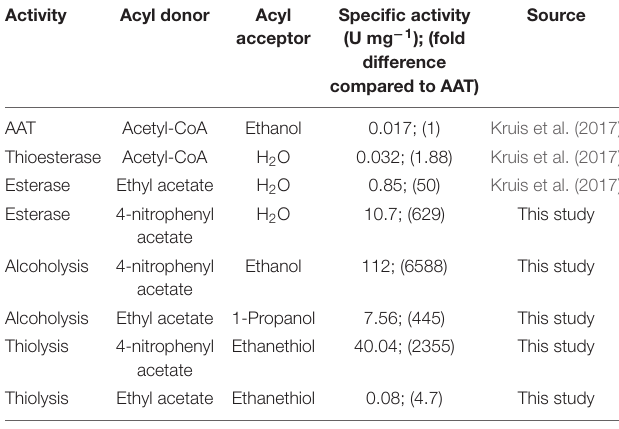
(0.08 ± 0.01 U mg − 1 ) as the acyl acceptor. In contrast,